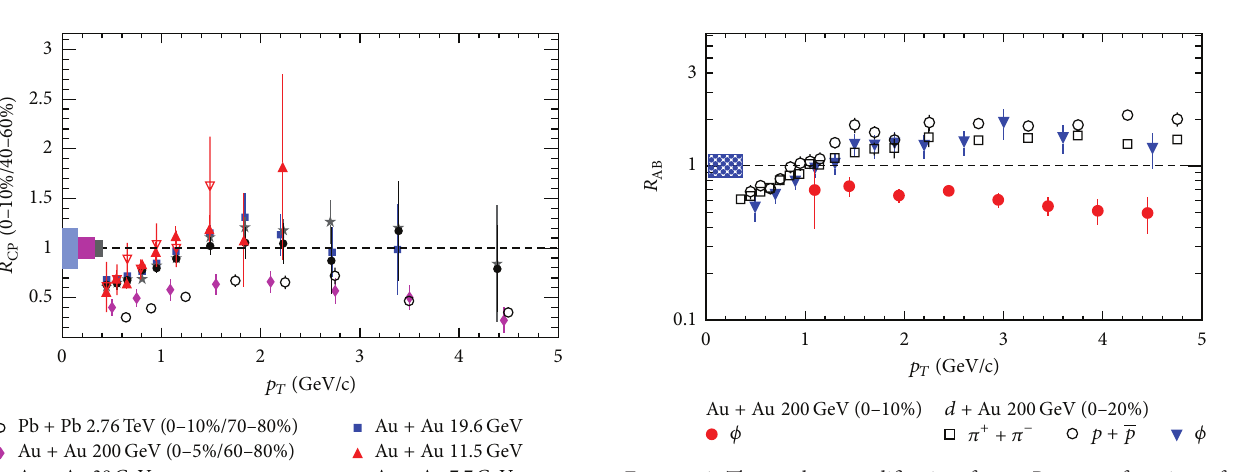
Figure 6: The nuclear modification factor 𝑅 𝑝 𝑇 in Au + Au and d + Au [18, 27] collisions at 200 GeV. Rectangular bands show the uncertainties associated with estimation of number of binary collisions. Error bars are quadrature sum of statistical and systematic uncertainties for 𝜙 in d + Au and only statistical for three other